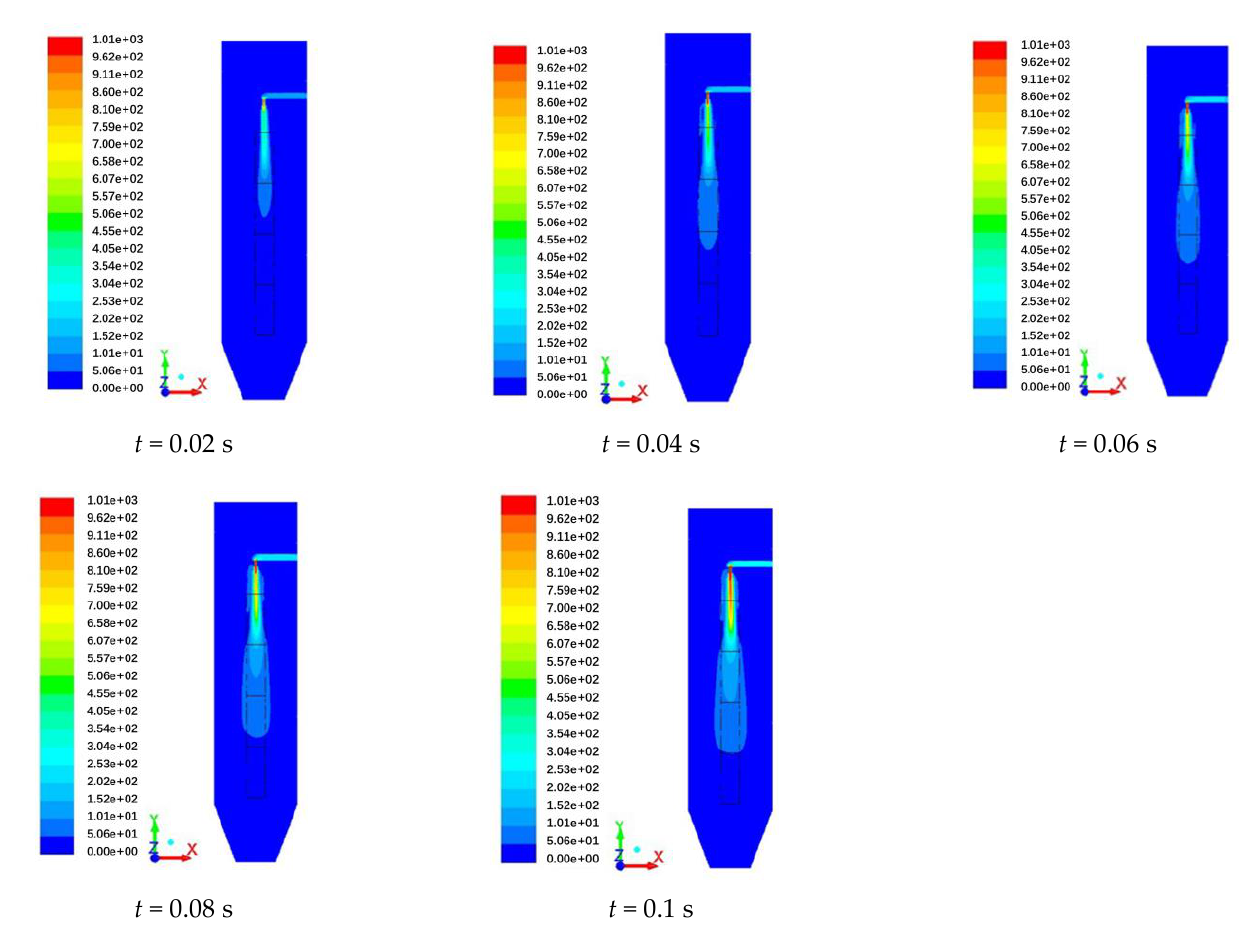
Figure 5. Cloud chart of velocity distribution under different pulse widths ( z = 0 mm, Unit: m/s).